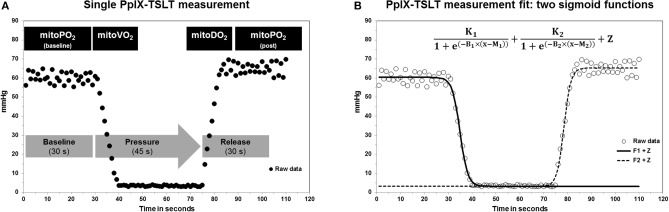
(A) Description of a single PpIX-TSLT measurement to obtain mitochondrial oxygen tension (mitoPO2), mitochondrial oxygen consumption (mitoVO2), and mitochondrial oxygen delivery (mitoDO2). (B) Illustration of the raw PpIX-TSLT data and the two sigmoid fit functions to estimate the PpIX-TSLT variables.